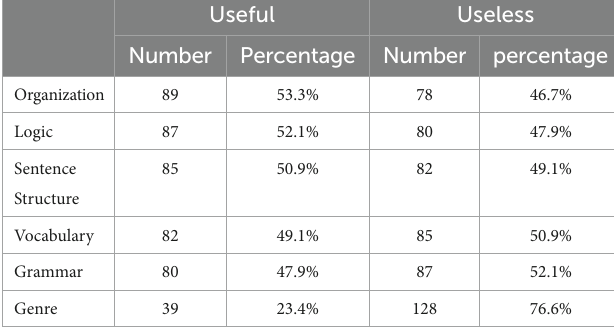
TABLE 4 Perceptions of cram the usefulness of EPT.